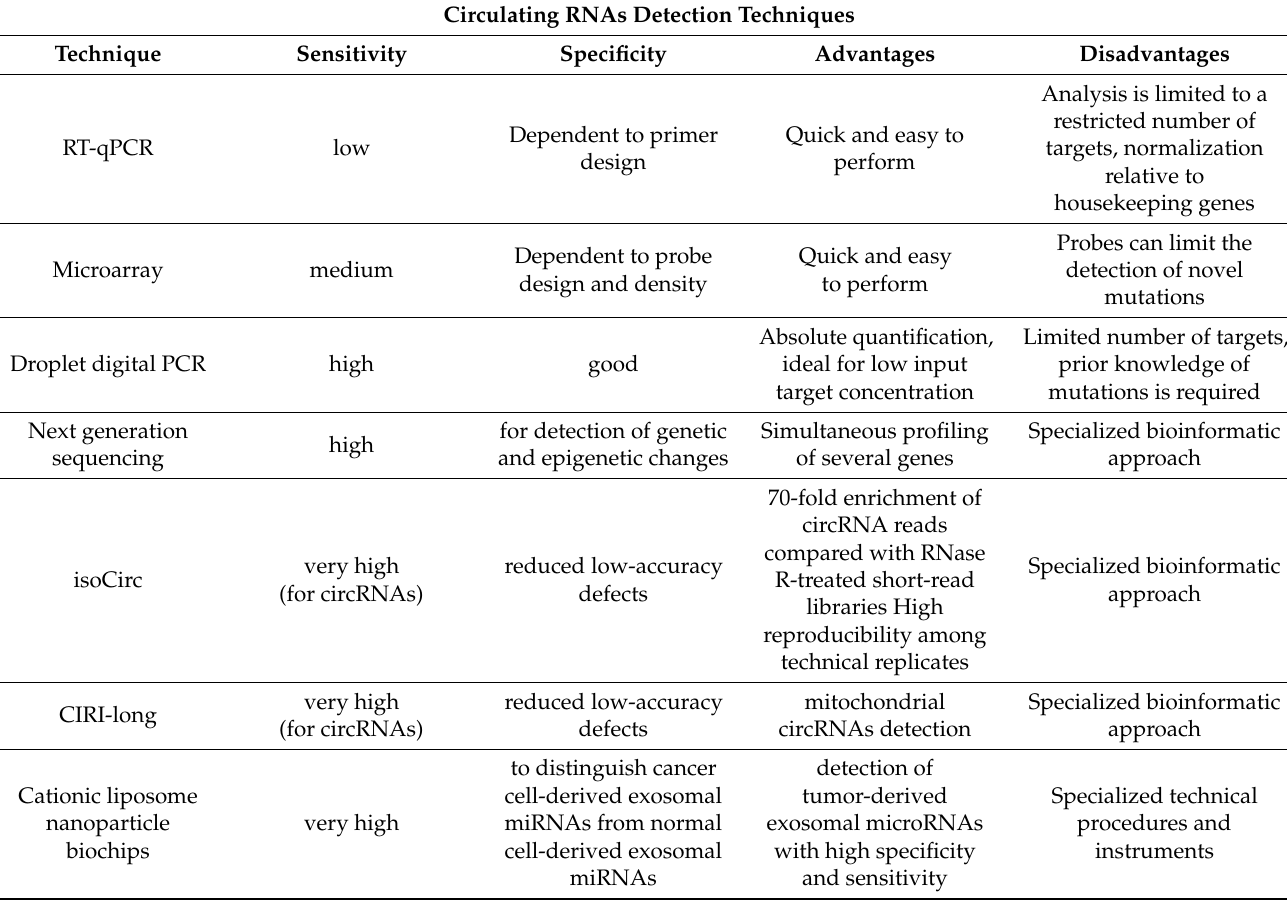
Table 3. List of methodological procedures for detecting circulating noncoding RNAs. Circulating RNAs Detection